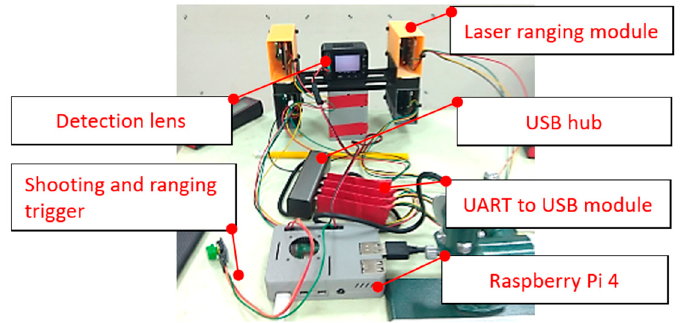
Figure 5. Architecture of the camera and laser ranging modules.